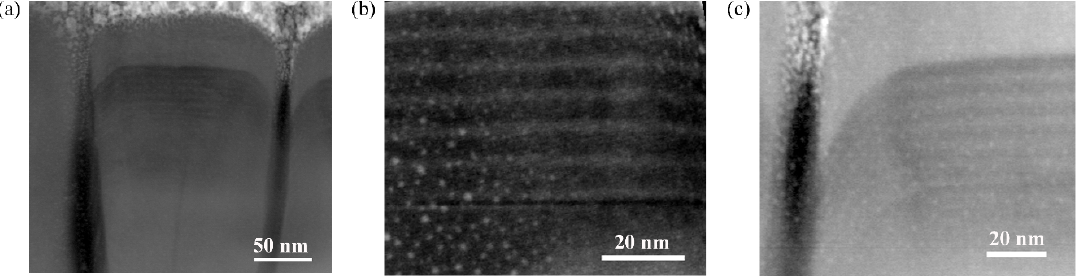
Figure 3. The structure of AlGaN nanorod LEDs: ( a ) cross-sectional STEM image of a single AlGaN nanorod LED; ( b ) the amplified MQWs structure; and ( c ) the curved downward MQWs and p-AlGaN. Figure 4 summarized the Raman spectra of graphene’s responses before and after MOCVD